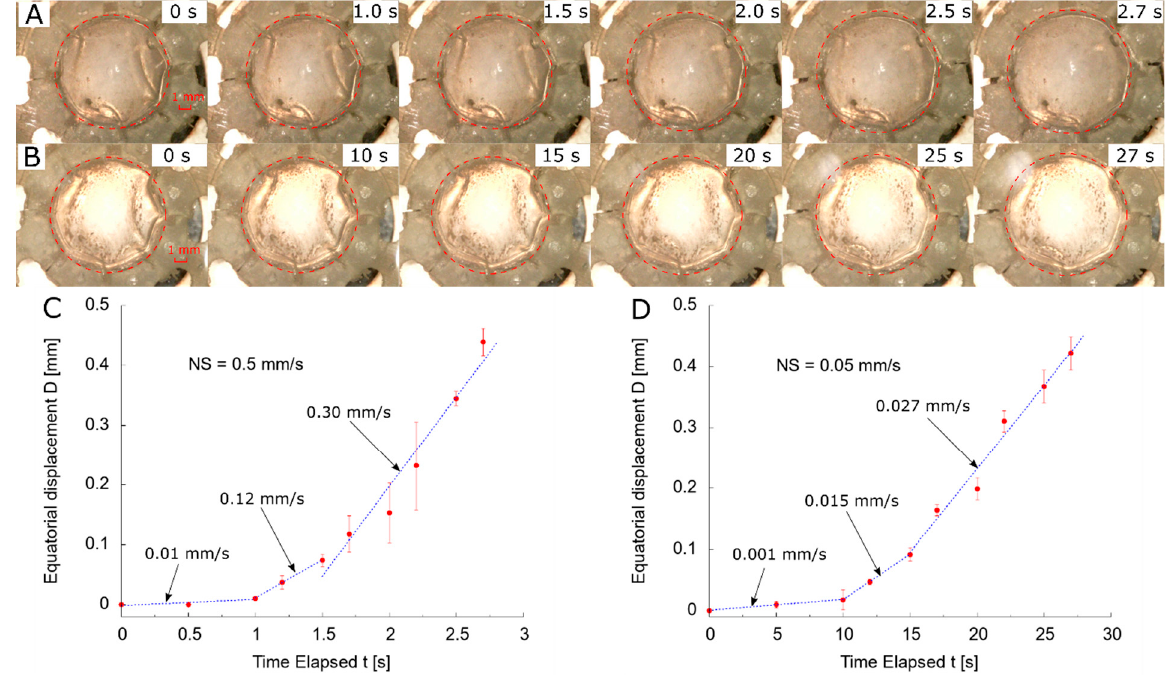
Figure 5. Stretching process from top view: ( A ) evolution of diameter at NS = 0.5 mm/s; ( B ) evolution of diameter at NS = 0.05 mm/s; ( C ) statistical displacement vs. time at NS = 0.5 mm/s; ( D ) statistical displacement vs. time at NS = 0.05 mm/s.